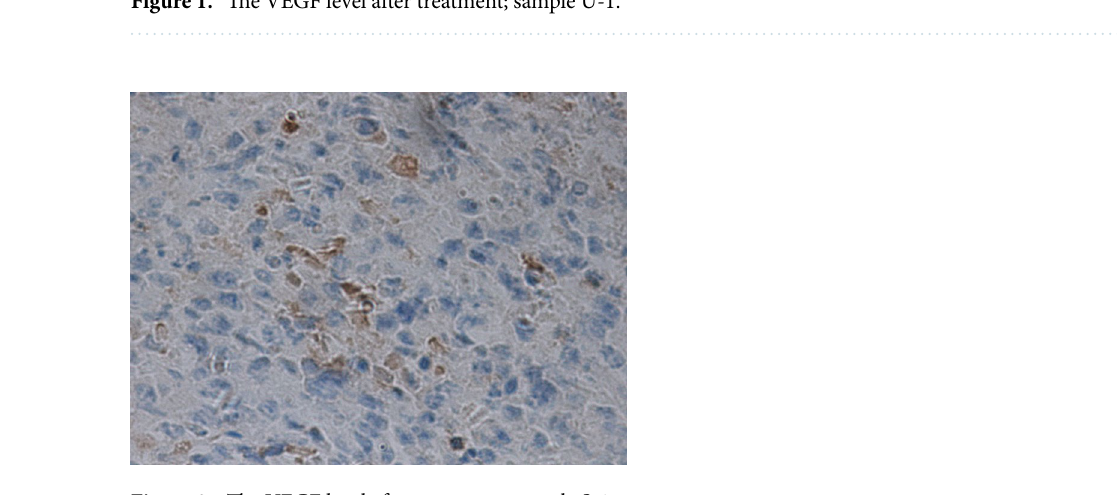
Figure 2. The VEGF level after treatment; sample